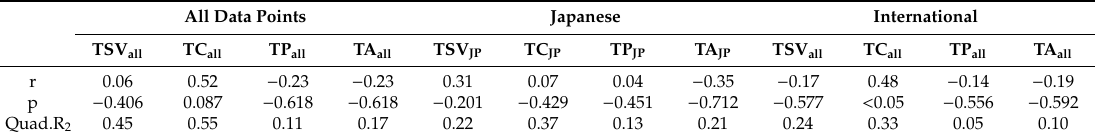
Table 5. Correlation between mean thermal responses and outdoor temperature.